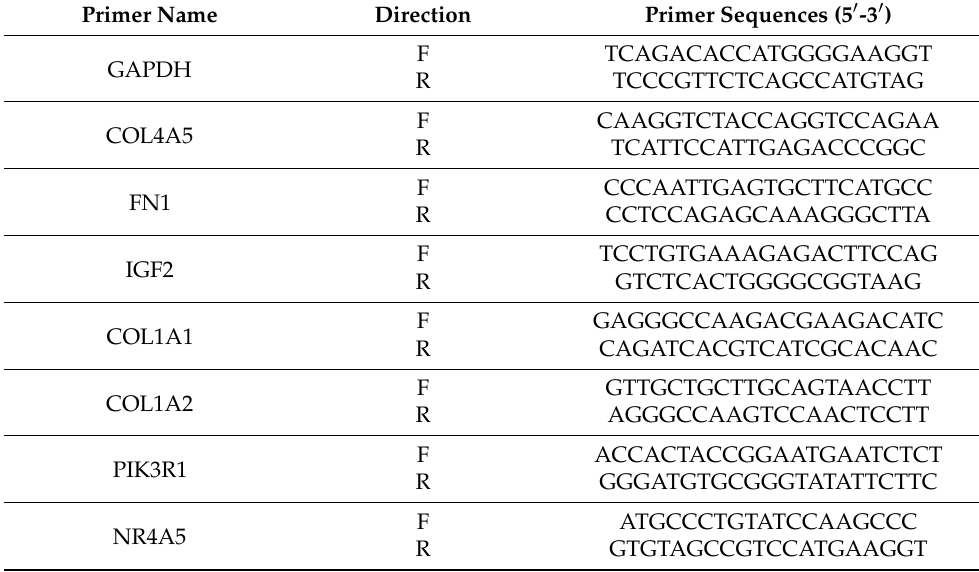
Table 1. Primer sequences for real-time